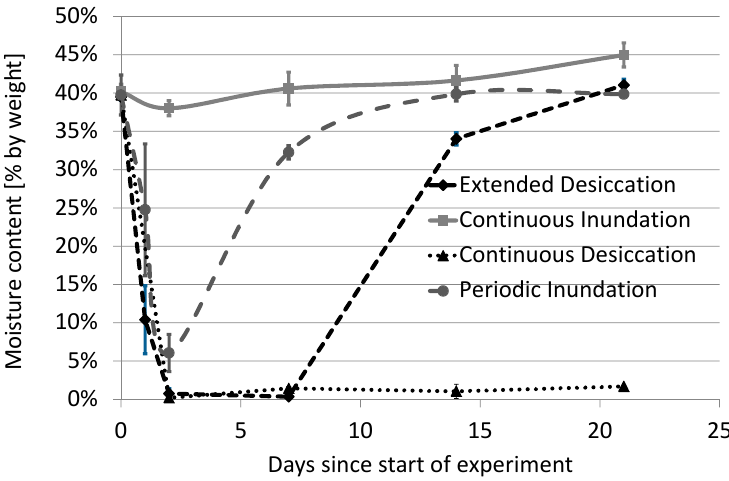
Figure 2. Levels of moisture content in four test sediment configurations during the experiment (error bars represent standard deviations around the mean values for each of the configurations).